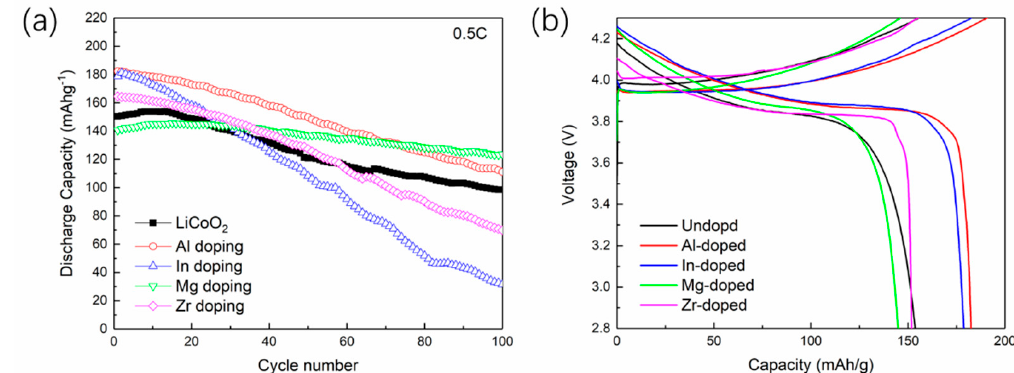
Figure 7. ( a ) Cycling performance comparison; ( b ) The charge-discharge profiles of doped and undoped LiCoO 2 .